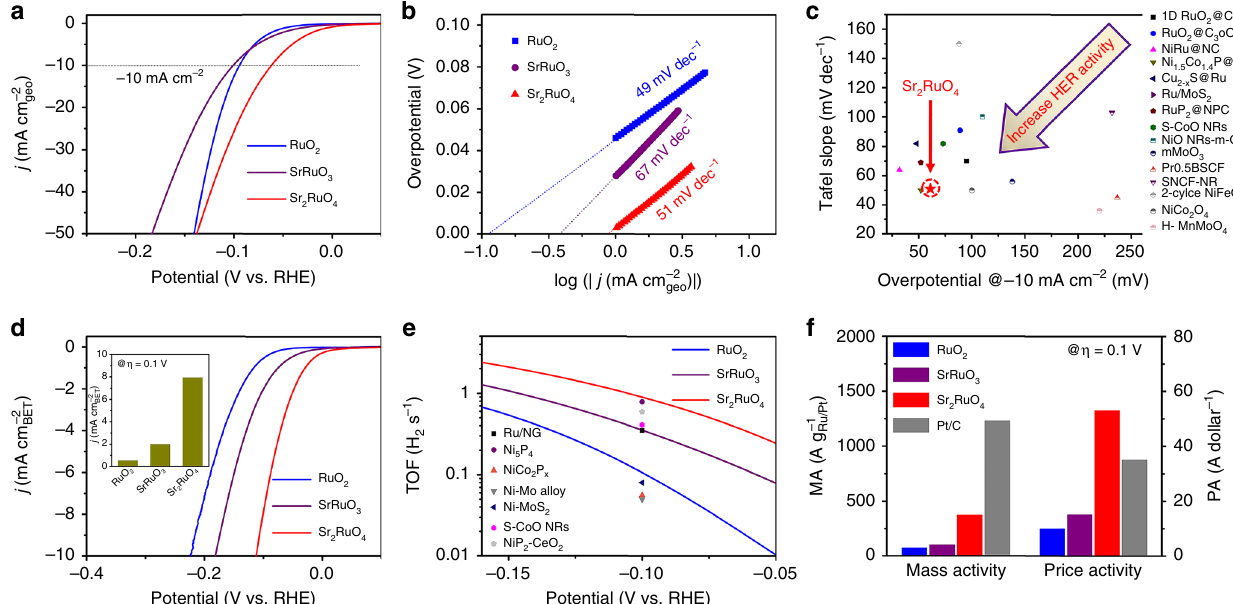
Fig. 2 Electrocatalytic HER activity. a Polarization curves and corresponding b Tafel plots of RuO 2 , SrRuO 3 , and Sr 2 RuO 4 catalysts in an Ar-saturated 1 M KOH solution. Scan rate, 5 mV s − 1 . c Alkaline HER activity comparison graph showing the Tafel slope with overpotential@ − 10 mA cm − 2 . d Speci fi c activity normalized to BET surface area of RuO 2 , SrRuO 3 , and Sr 2 RuO 4 catalysts as a function of potential. Inset: speci fi c activity at the overpotential of η = 0.1 V. e The relationship between TOF and the tested potentials for RuO 2 , SrRuO 3 , and Sr 2 RuO 4 electrocatalysts in 1 M KOH solution. TOF values of some well- known HER catalysts in the literature are also shown for comparison. f Mass activity (MA) and price activity (PA) of RuO 2 , SrRuO 3 , Sr 2 RuO 4 and Pt/C at the overpotential of η = 0.1